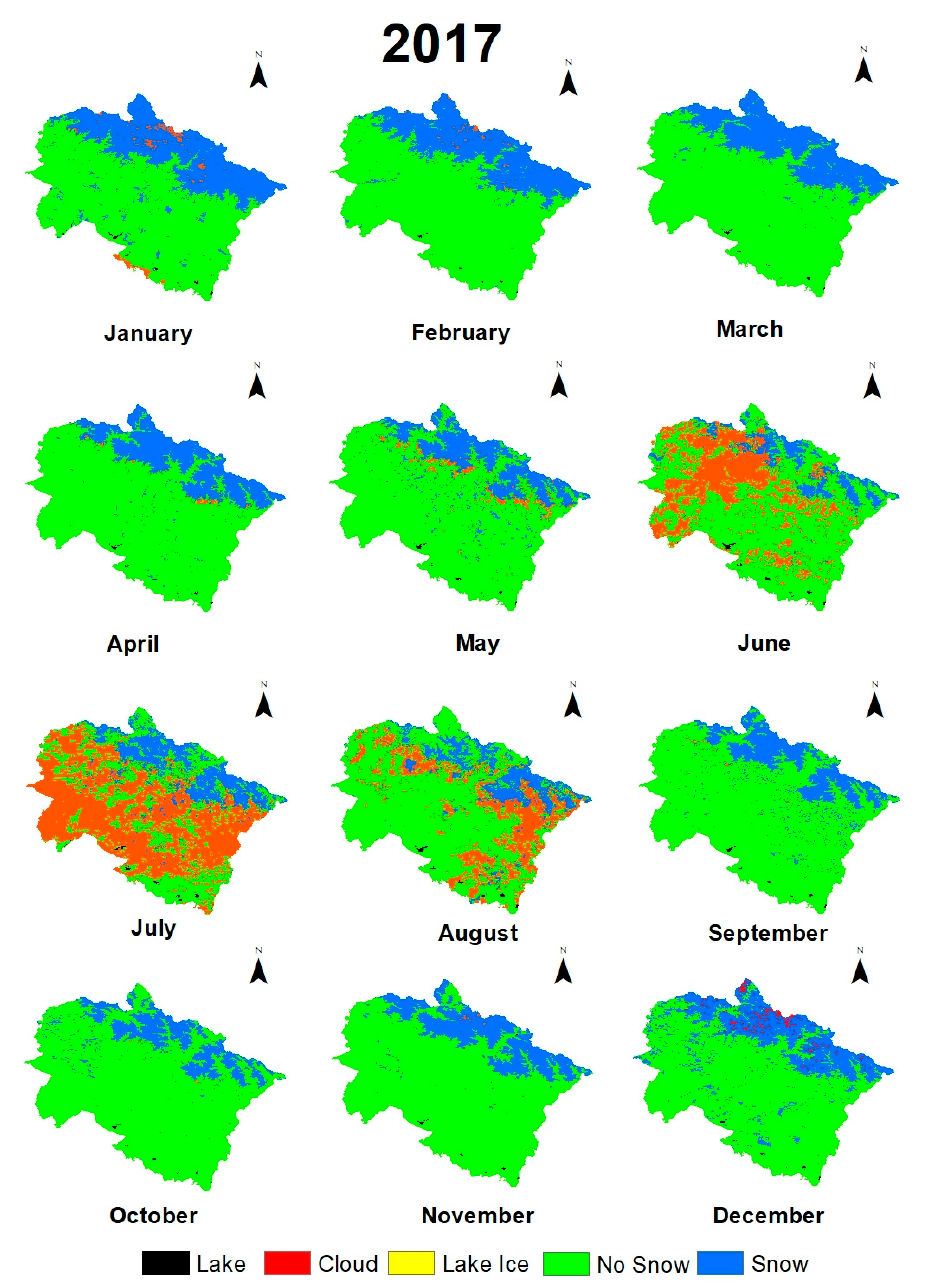
Figure 5. Monthly fluctuations of snow cover in Uttarakhand in 2017.